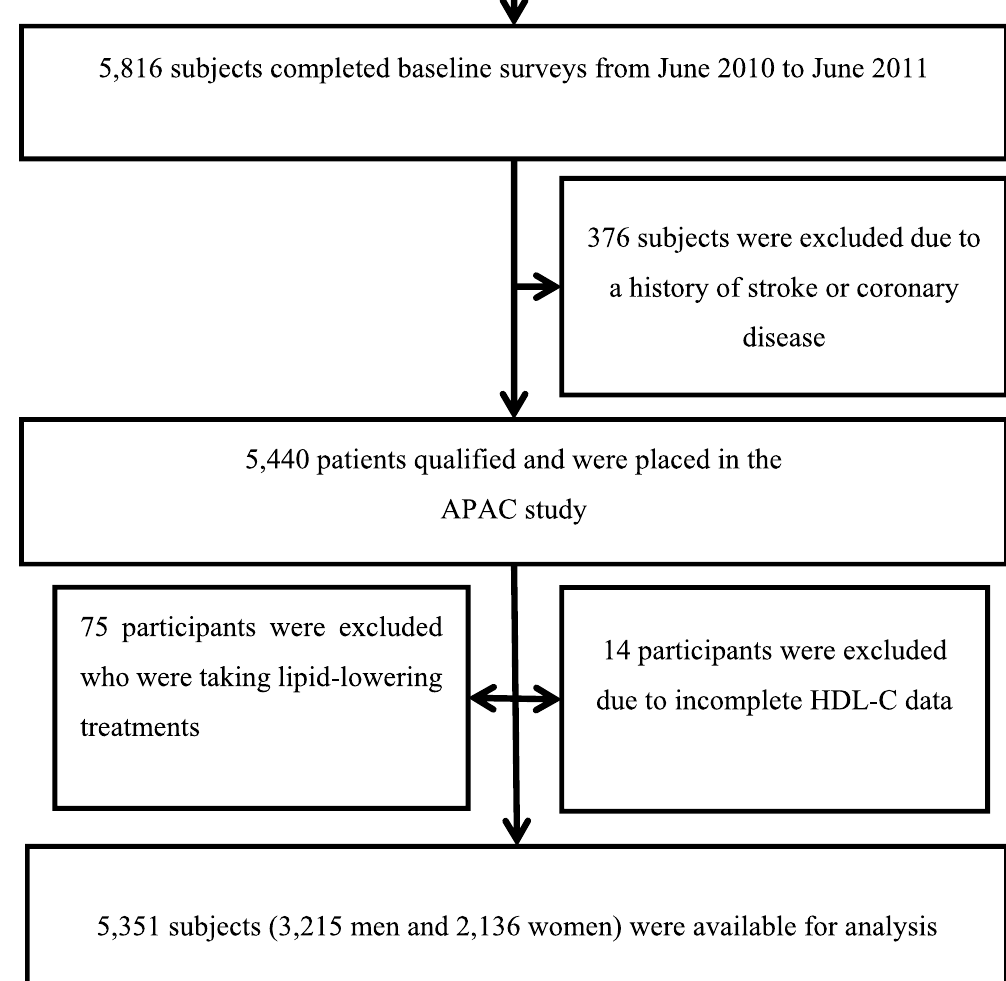
Figure 1. Flow chart of the